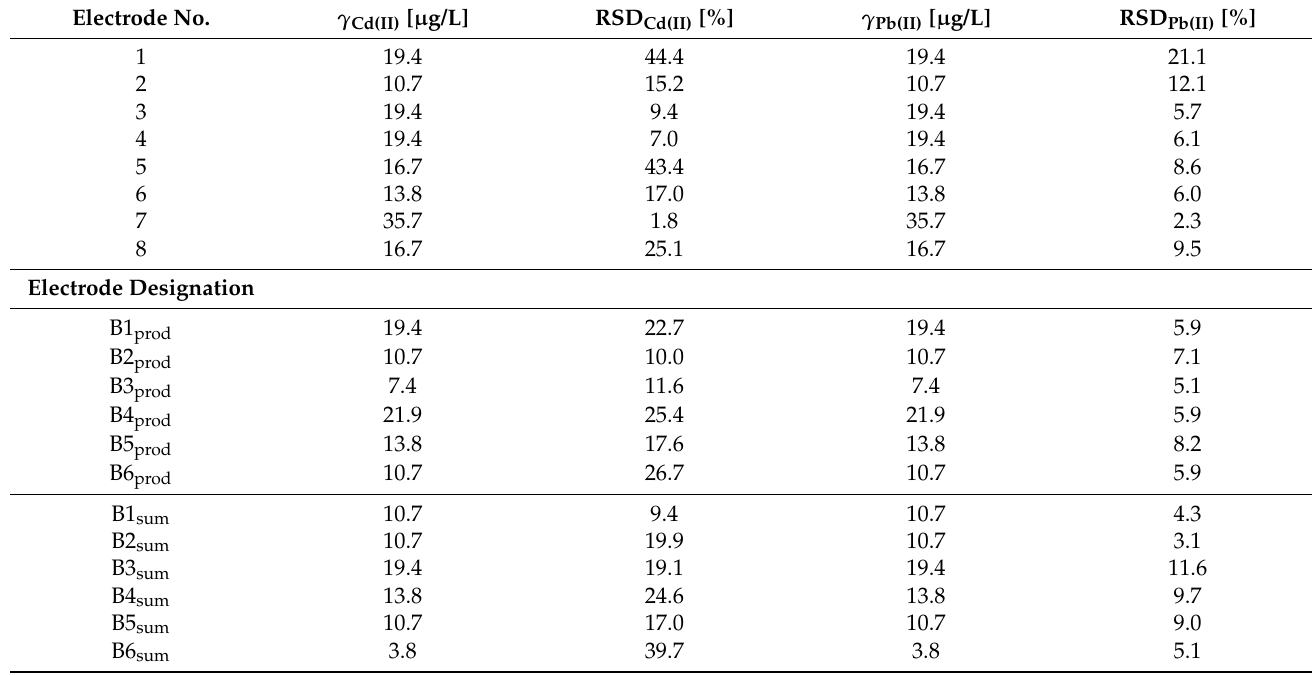
Table 7. RSD values, representing the precision of the